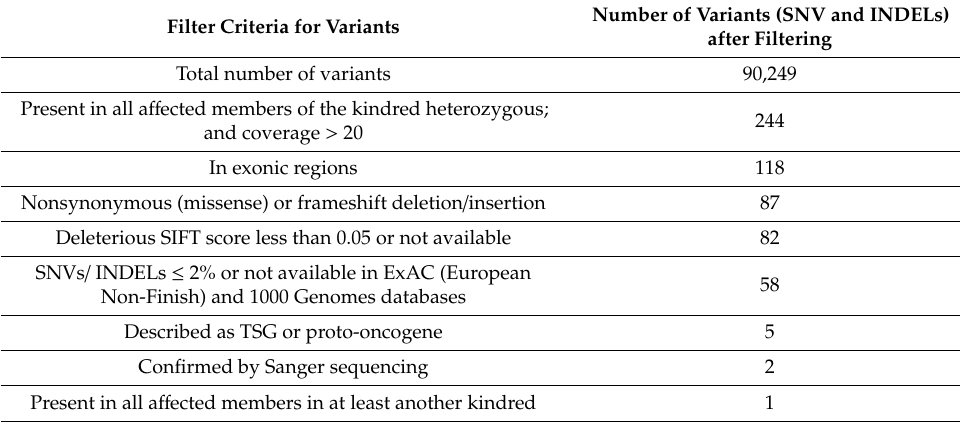
Table 1. SNVs and INDELs in Kindred 1 by filtering steps of whole-exome sequencing data. Number of Variants (SNV and INDELs) Filter Criteria for Variants after Filtering Total number of variants 90,249 Present in all a ff ected members of the kindred heterozygous; 244 and coverage > 20 In exonic regions 118 Nonsynonymous (missense) or frameshift deletion / insertion 87 Deleterious SIFT score less than 0.05 or not available 82 SNVs / INDELs ≤ 2% or not available in ExAC (European 58 Non-Finish) and 1000 Genomes databases Described as TSG or proto-oncogene 5 Confirmed by Sanger sequencing 2